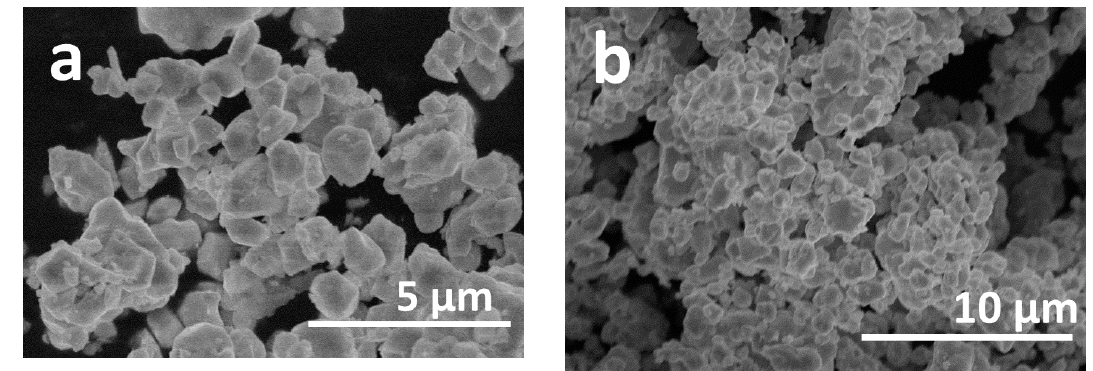
Figure 3. SEM micrographs of BFO powders annealed at 650 °C under different magnification ( a and b ).